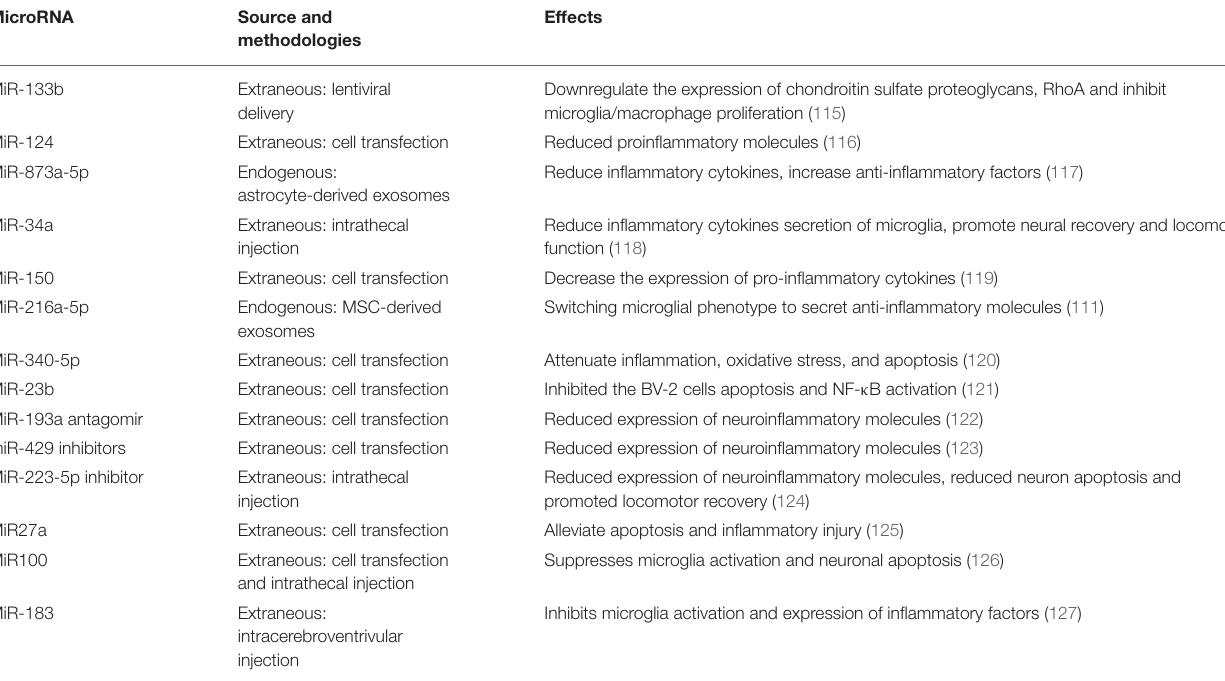
TABLE 1 | MicroRNAs therapy. MicroRNA Source and